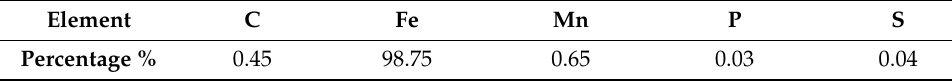
Table 2. Chemical compositions of AISI 1045.